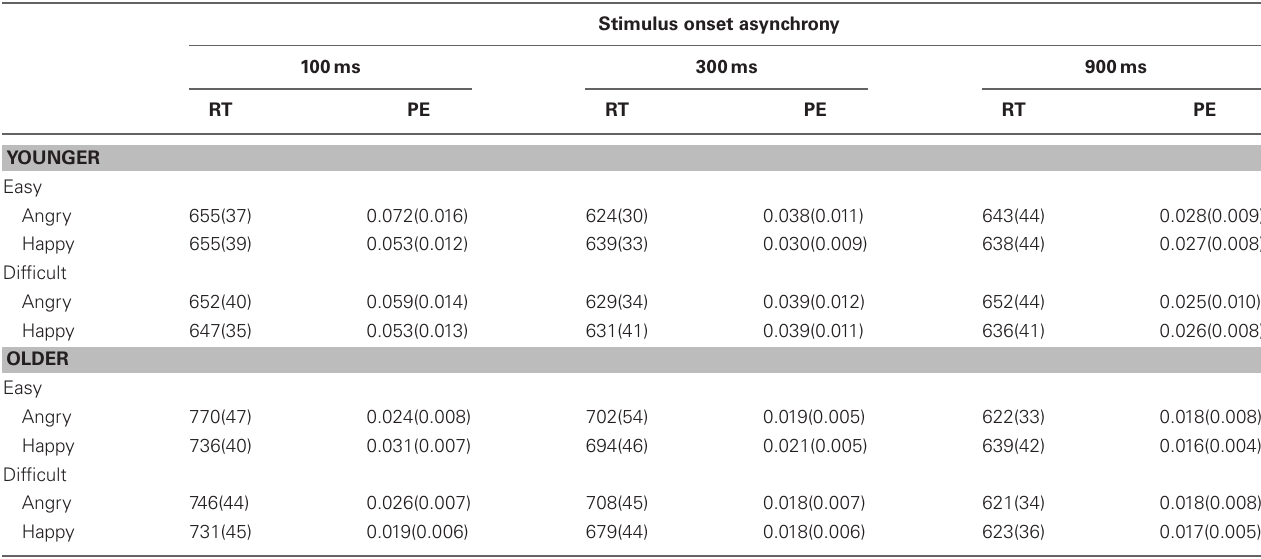
Table 1 | Mean response time (RT in ms) and proportion of errors (PE) for Task 1 as a function of age group (younger vs. older), Task-2 difficulty (easy vs. difficult), Task 2 emotion (angry vs. happy), and stimulus onset asynchrony (100, 300, and